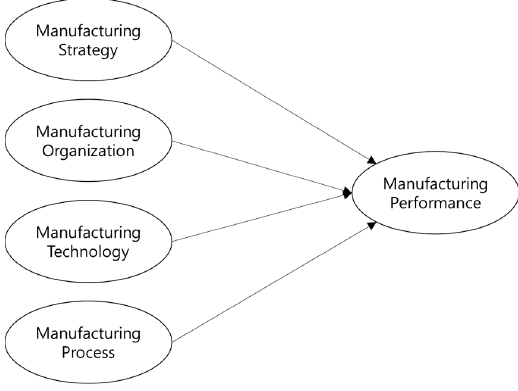
Figure 1. Research framework.